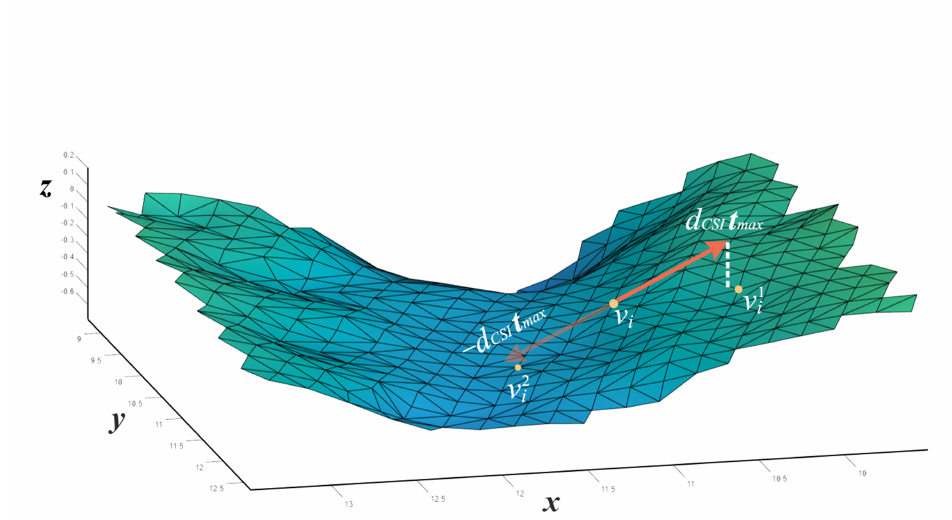
Figure 4. Relative vertices localization. For v i , a 3D point located at a distance of d CSI in t max direction is identified. The 3D point is projected on the mesh and the closest vertex is obtained as the relative vertex v 1 . Similarly, v 2 is identified using the opposite direction of t max i i